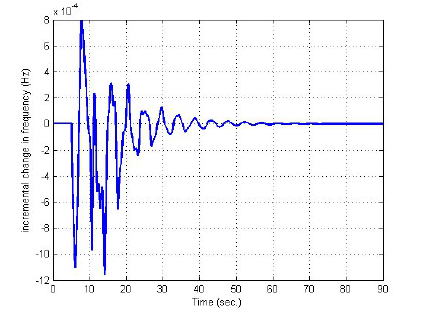
Fig. 15: ACE in control area 1 (Case 3)